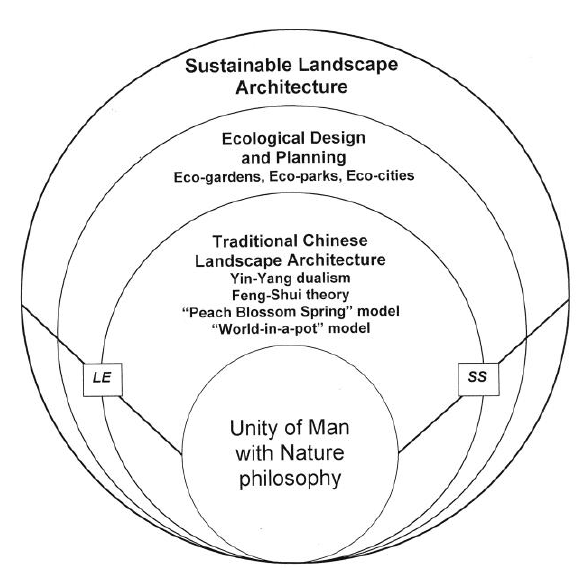
Fig. 2. A Conceptual framework for a sustainable Chinese Landscape Architecture ( LA ) and parallel of Sustainability Science ( SS ) [after Chen and Wu 2009: